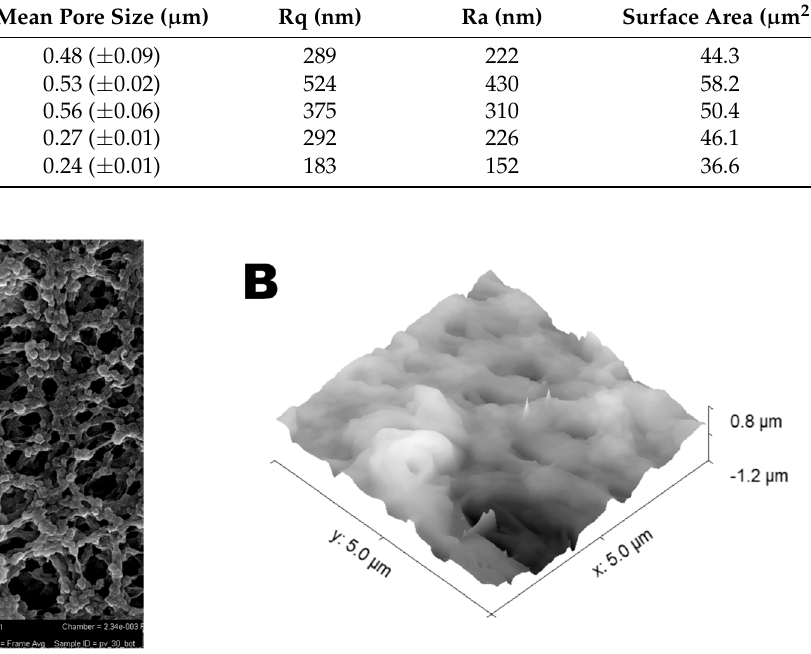
Table 1. Properties of the pristine PVDF membrane and its graphene-based composites. Porosity and mean pore size analyses were performed 3 times for every sample and the values are reported as mean ± standard deviation.